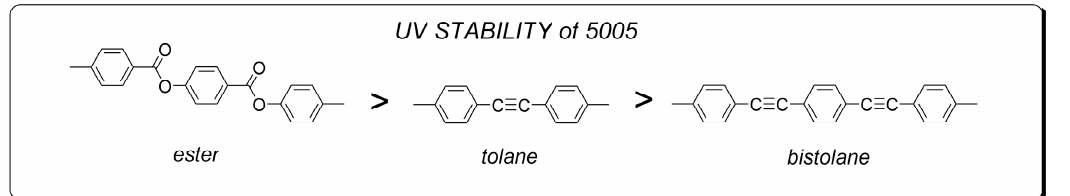
Figure 8. Comparison of UV stability of 5005 mixture ingredients.